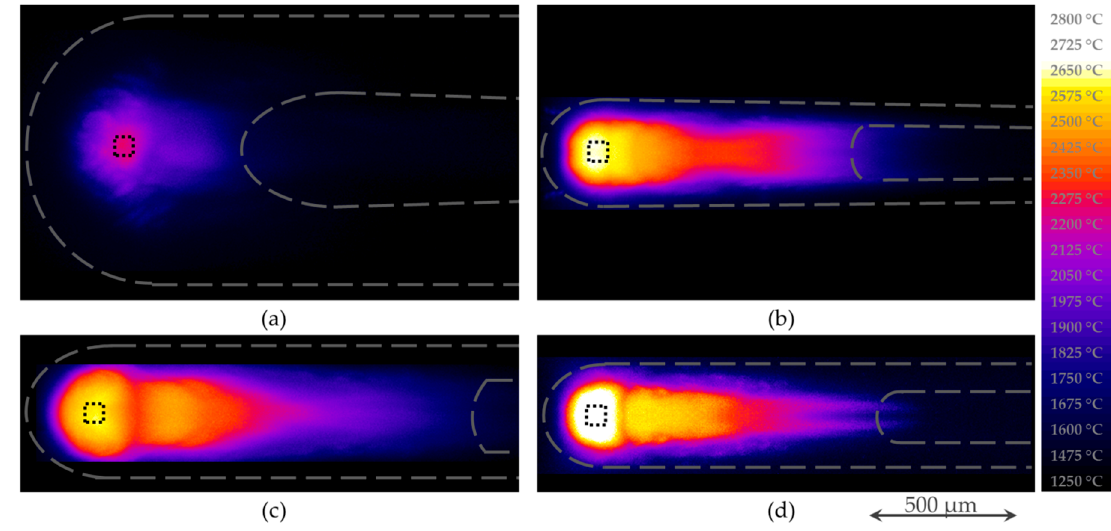
Figure 16. Distribution of maximum temperature 𝑇 (cid:3036),(cid:3037)(cid:3040)(cid:3028)(cid:3051) calculated with e = 1 from all single images within the complete measurement period of 500 ms of 12 mm stainless steel cut with the following parameters: ( a ) Set #1: Static beam shaping; and different values of the longitudinal, linear beam oscillation parameters: ( b ) Set #2: 300 µm amplitude and 500 Hz frequency; ( c ) Set #3: 550 µm amplitude and 500 Hz frequency; ( d ) Set #4: 300 µm amplitude and 2000 Hz frequency; the square marks the submatrix T (cid:2926),(cid:2926) (t) positioned at the highest maximum temperature.